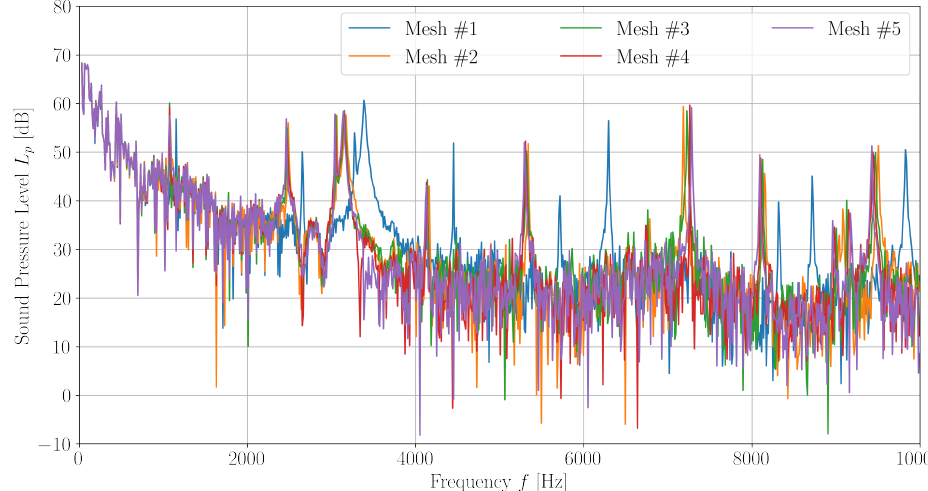
Figure 6. Sound pressure level at observer 10 m from center of the cavity for finite element mesh independence study.